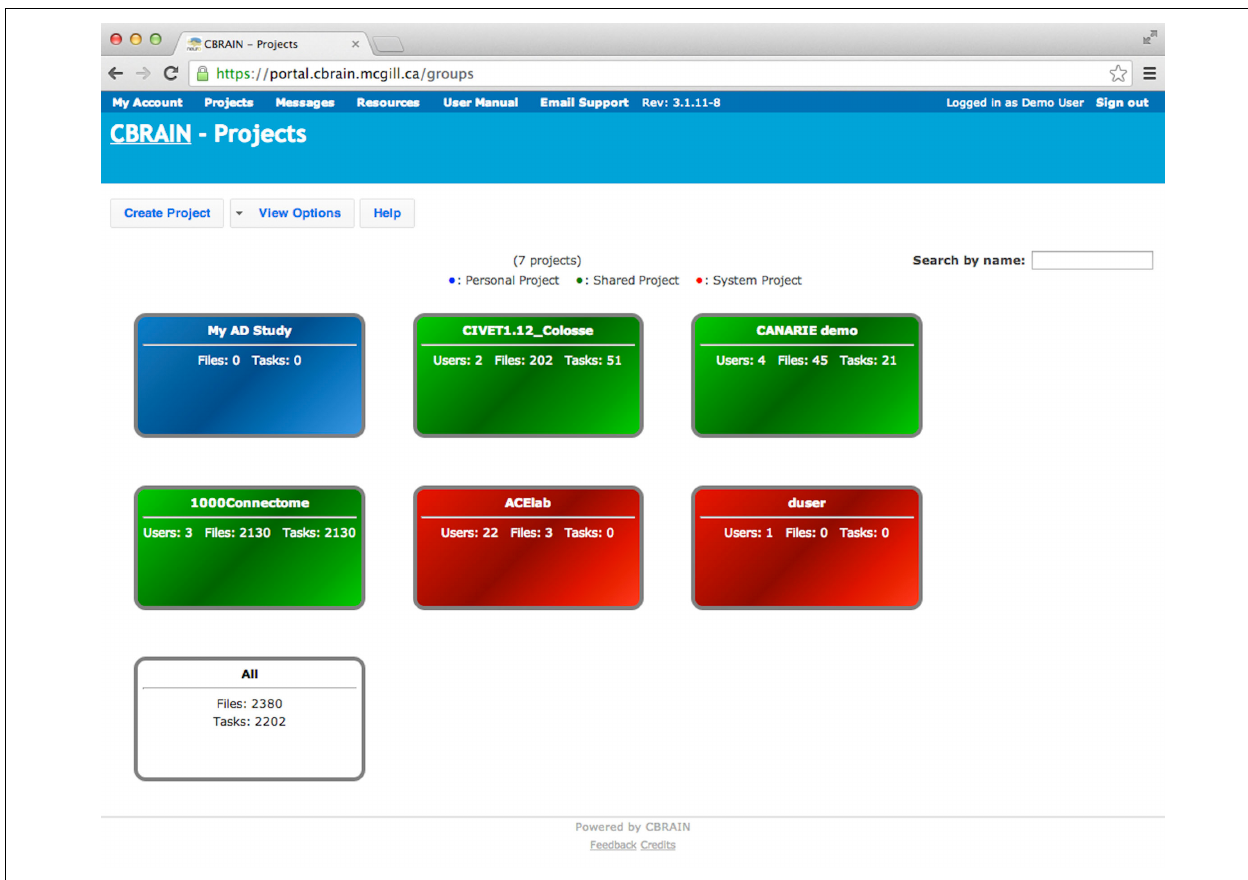
FIGURE 2 | CBRAIN portal: project view. Authenticated users can see a representation of the various projects they own. Projects are color coded: blue for personal projects, green for shared projects, red are default user or site projects, and white allows access to all files owned by this user.